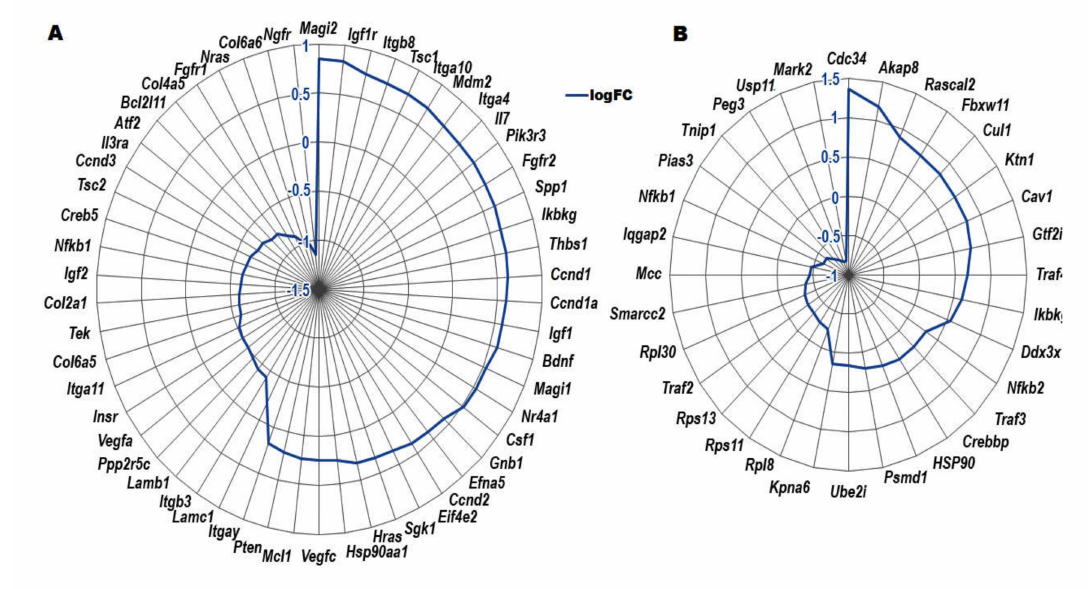
Figure 4. The DEGs are involved pathways like ( A ) PI3K-Akt signaling pathway, ( B ) TNF- α NF- κ B signaling pathway respectively. The up-regulated and down-regulated genes extend edge to the center point were based on the logFC values. The negative values indicate the down-regulated genes, and positive values indicate the up-regulated genes in KO RPE versus WT